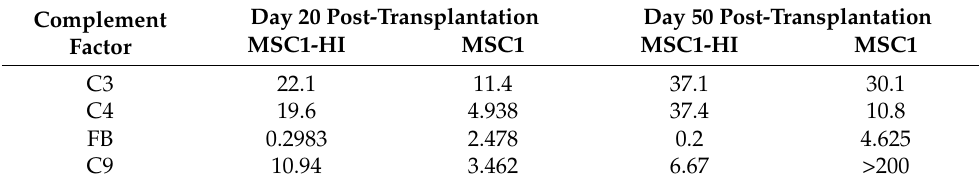
Table 2. Complement deposition (C3, C4, FB and C9) on MSC1-HI and MSC1 grafts.